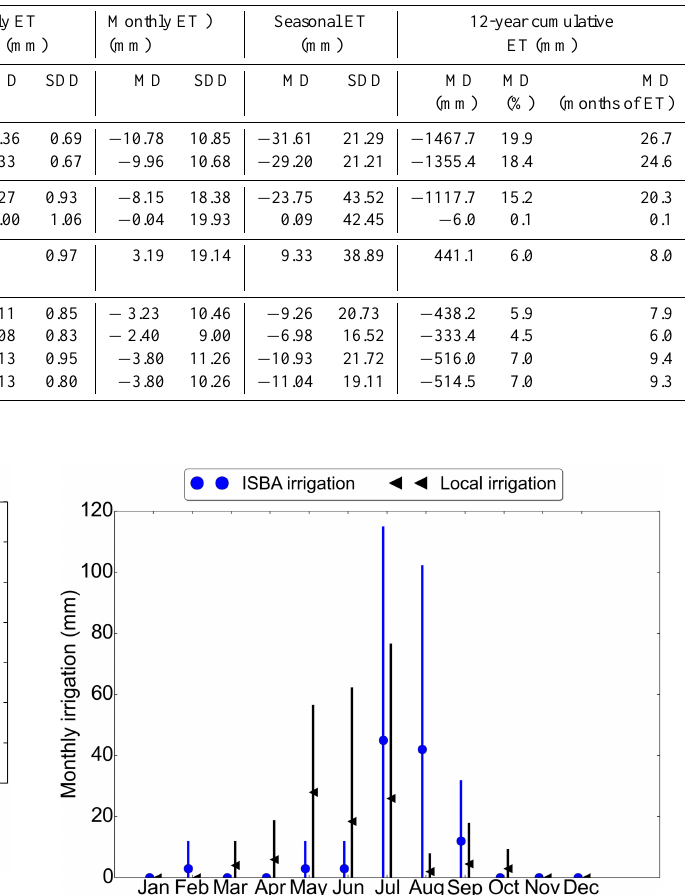
Figure 8. Comparison of the ECOCLIMAP-II LAI with the in situ LAI over the crop cycles of the 12-year crop succession. Crop and inter-crop periods are represented by grey and white backgrounds, respectively.